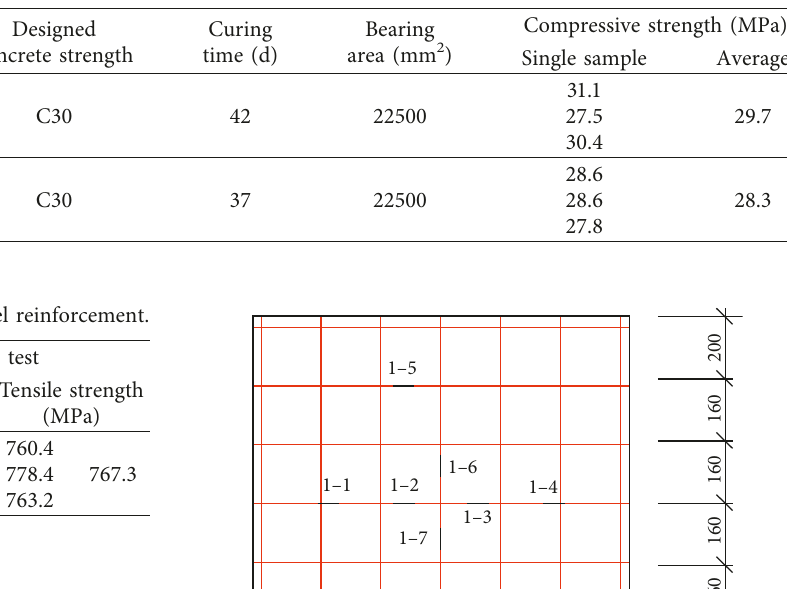
Table 2: Strengths of concrete samples.